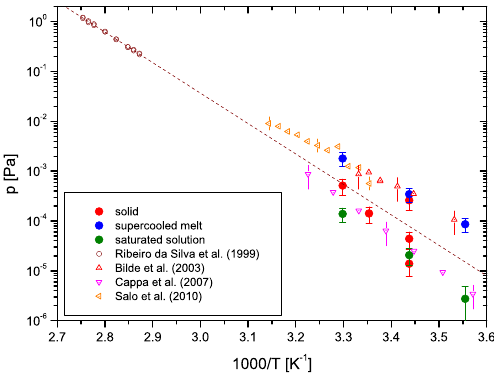
2 of a solid glutaric acid par- Fig. 4. Evaporation rate dr Fig. 5. Vapor pressure from evaporation rates of glutaric acid ver- dt ticle (of initial size 2.91µm equivalent radius) after efflo- sus temperature. Our measurements for the solid, (supercooled) rescence under dry conditions (RH < 1%) at T = 290 . 9K. liquid, and saturated solution states are plotted as indicated in the The rate changes with time from an initial rate (blue key. For comparison, a selection of literature data is plotted as 2 well. Dotted line: extrapolation of high temperature data ( Ribeiro =− 1 . 48 × 10 − 4 µm 2 s − 1 to a rate of dashed line) of dr dt da Silva et al., 1999) to ambient temperatures. Note that the two dr 2 =− 7 . 82 × 10 − 6 µm 2 s − 1 (orange dashed line) after almost dt data points of the solid at the highest and lowest vapor pressures a day of evaporation. (Outliers in the radius data are due to noise in at 1 /T = 3 . 44 × 10 − 3 K − 1 originate from the same particles, but at the optical resonance spectra for non-spherical particles (Zardini et different times after efflorescence, see Fig. 4 and discussion in the al., 2009, 2010) and do not imply sudden changes in radius.)